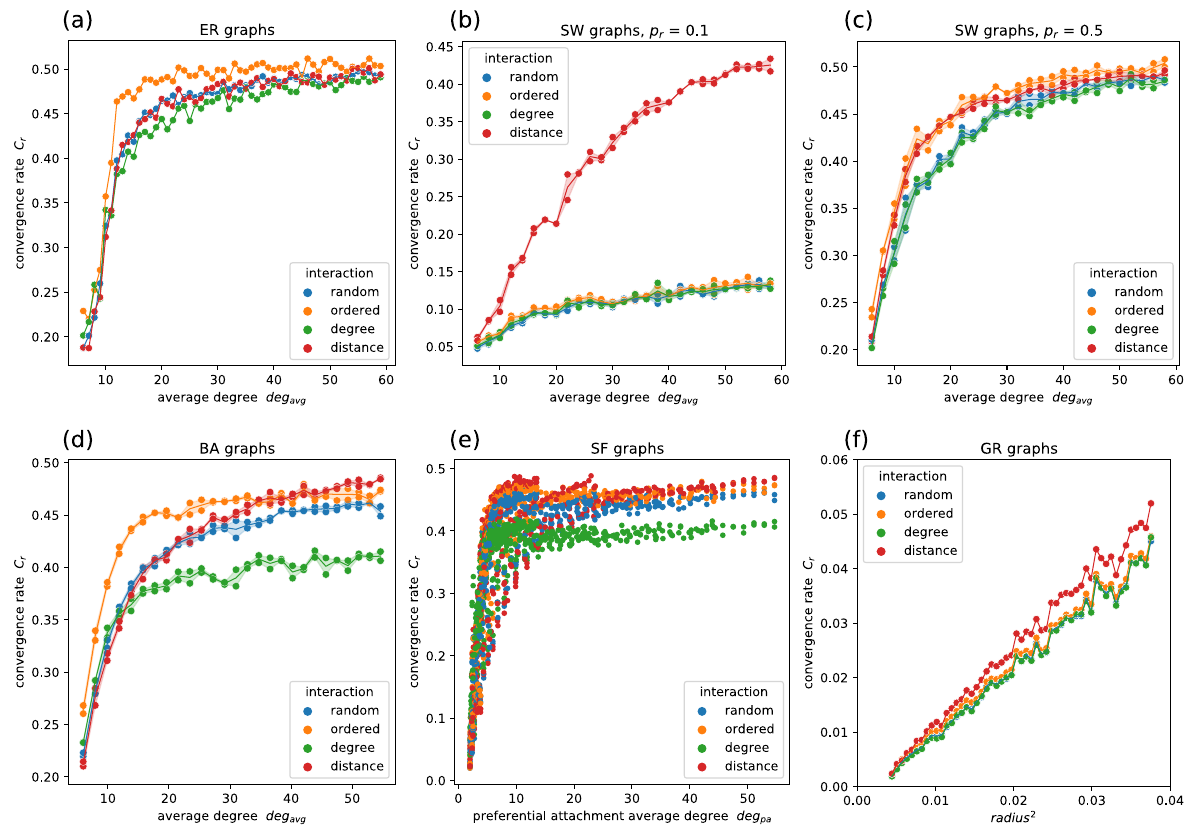
Figure 12. Performance of four gossip algorithms in ( a ) ER graphs, ( b ) SW graphs with low p r , ( c ) SW graphs with high p r , ( d ) BA graphs, ( e ) SF graphs with adjusted clustering, and ( f ) GR graphs. Each convergence value is the average convergence rate obtained over 100 simulation